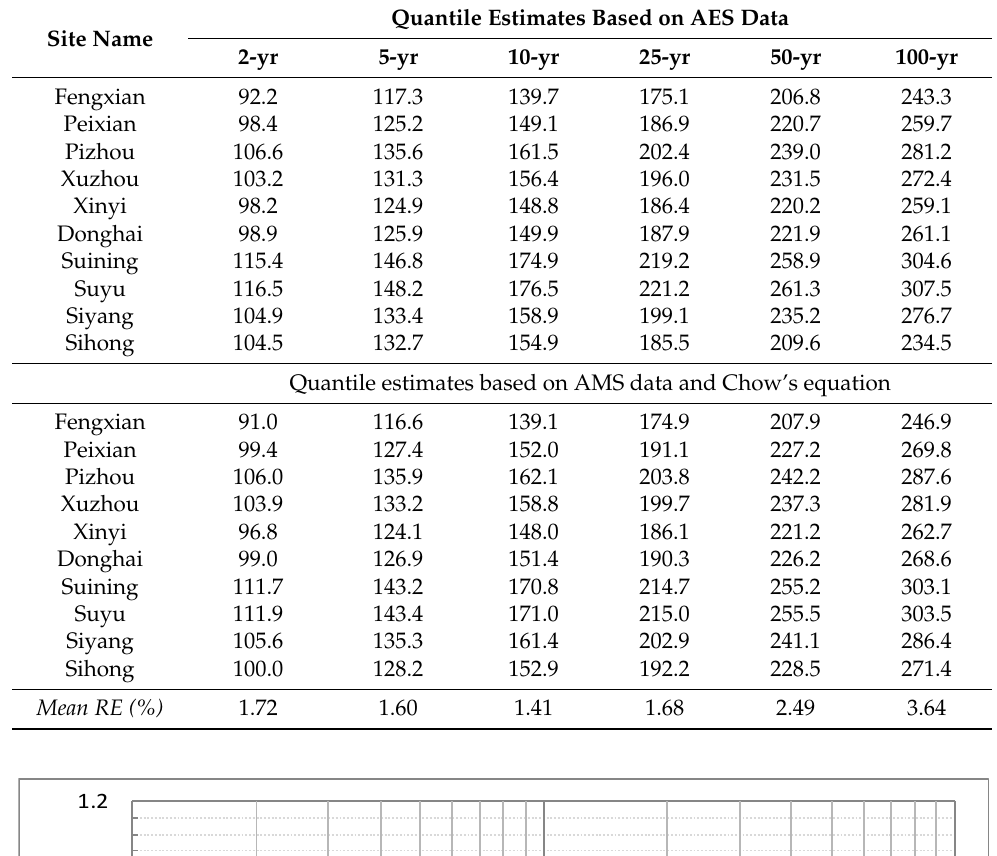
Table 4. Quantile estimates of extreme precipitation for a 1-day duration with different return periods in homogeneous region I.